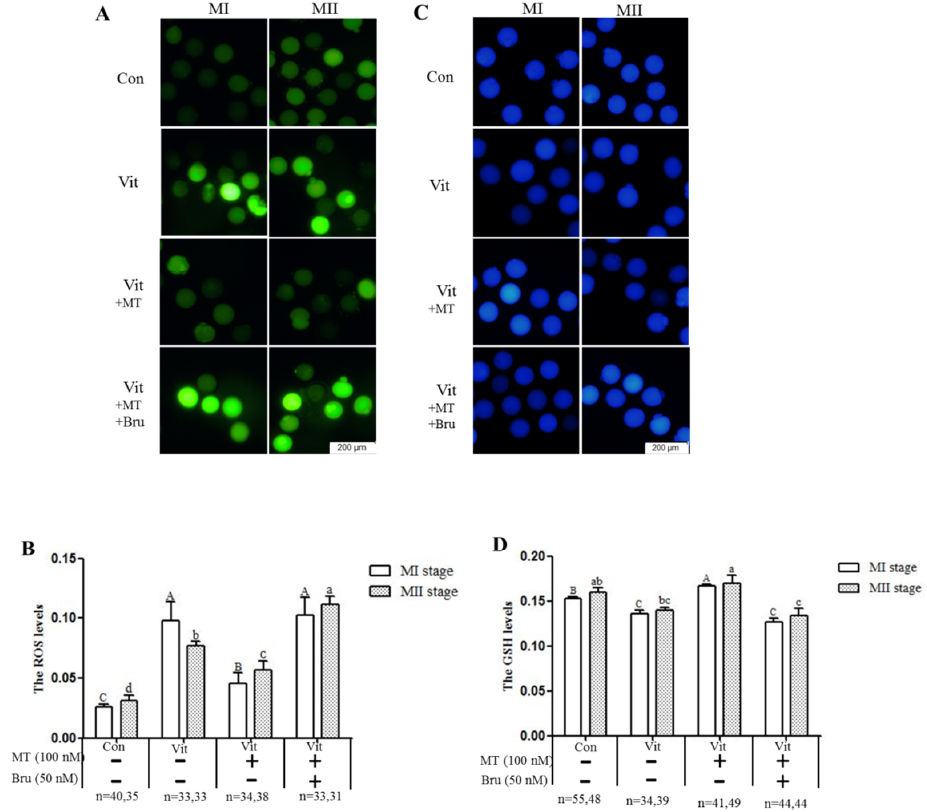
Figure 3. Effects of melatonin (MT) and Brusatol (Bru) on ROS and GSH levels during in vitro maturation of vitrified-warmed mouse GV oocytes. The four experimental groups had differences in ( A , B ) ROS levels (H2DCFDA fluorescence) and ( C , D ) GSH levels (Cell Tracker Blue staining). Data are expressed as mean ± SEM from three independent experiments. Different superscripts A (a), B (b), C (c), and D (d) indicate difference ( p < 0.05) between groups at the same stages. Scale bar = 200 µm. The four experimental groups: control (Con), vitrification (Vit), vitrification+ melatonin (Vit + MT), and vitrification + melatonin + Brusatol (Vit + MT + Bru). Notes: MI: metaphase I; MII: metaphase II.